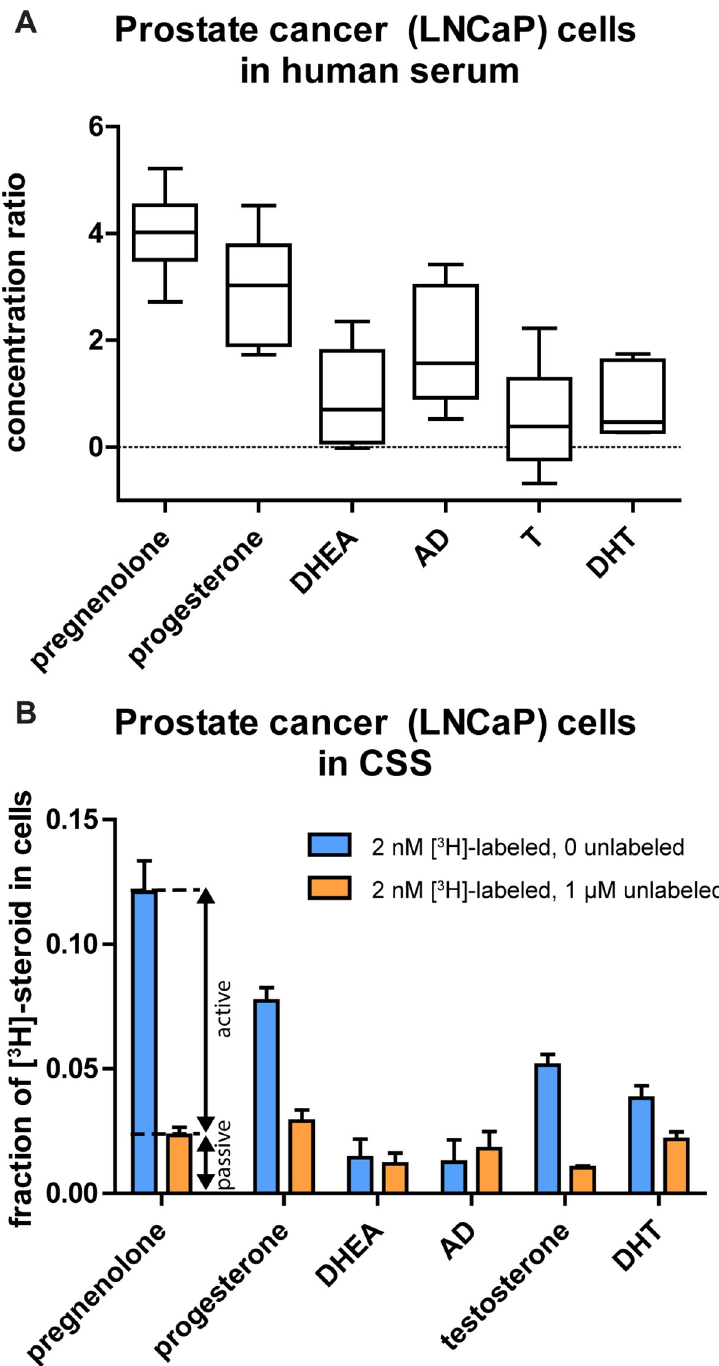
Fig 10. Serum proteins prevent most of the passive cellular uptake of steroids. (A) Box and whisker plot of concentration ratios for six steroids (2 nM [ 3 H]-labeled steroid with 1 μ M unlabeled steroid) in LNCaP cells in human serum. Experiments were performed in triplicate with at least two independent experiments for each steroid. Cellular steroid content was corrected by control experiments with no cells to account for effects of residual serum; note that this resulted in some values < 0 for certain steroids, which is not physically possible, but these values were included to fully account for variability resulting from measurement uncertainty. Ratio for pregnenolone was greater than ratios for DHEA, AD, testosterone, and DHT (Tukey’s multiple comparison test after one-way ANOVA, p < 0.001 for all four). Ratio for progesterone was greater than ratios for DHEA (p = 0.003), testosterone (p < 0.001), and DHT (p = 0.002). For pregnenolone vs. progesterone, p = 0.17. (B) Fractions of total steroids (serum plus cells) collected